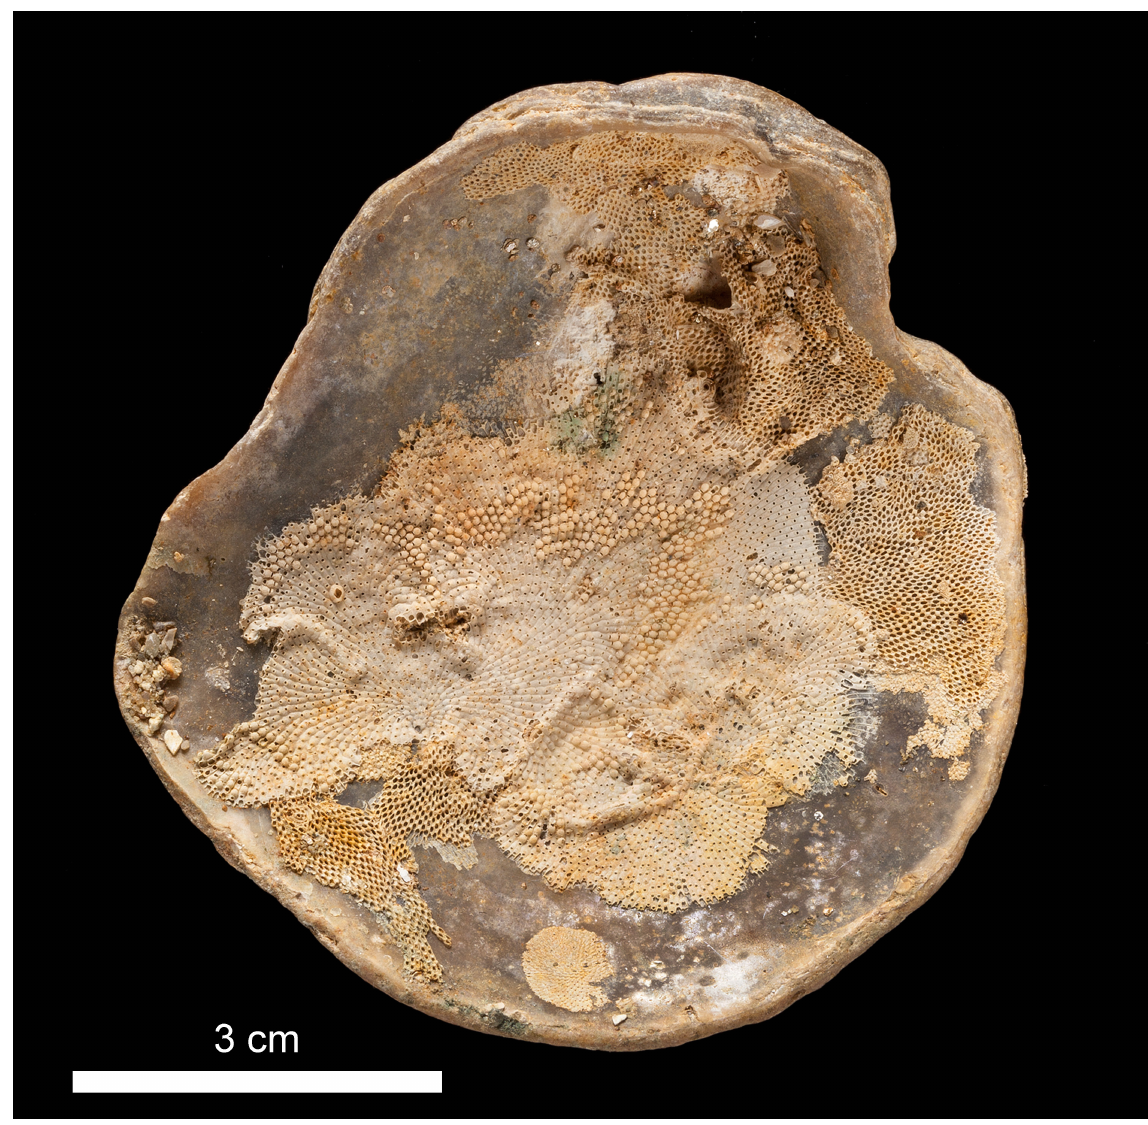
Fig. 4. Powellitheca waipukurensis (Waters, 1887) comb. nov. NHMUK BZ 7744, Nukumaruan, Pleistocene, Nukumaru Limestone, Waiinu Beach. Two colonies of P. waipukurensis encrusting a bivalve shell, competing with other bryozoan species for space. Note the band of fertile zooids with large, globular